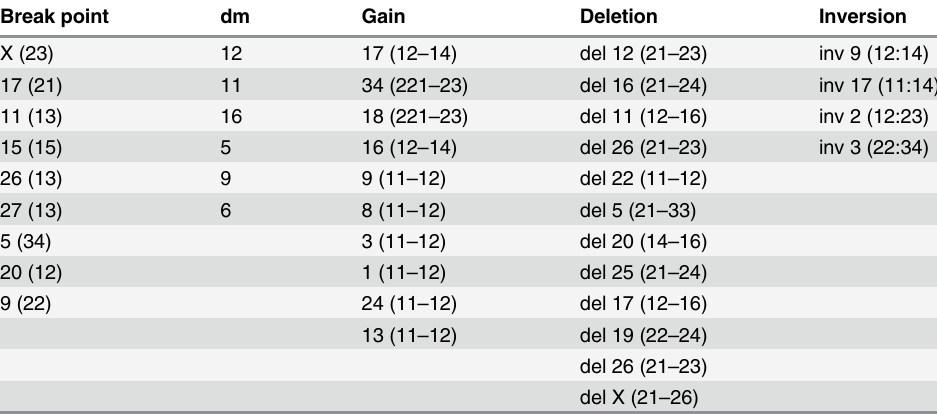
Table 2. Aberration found in the